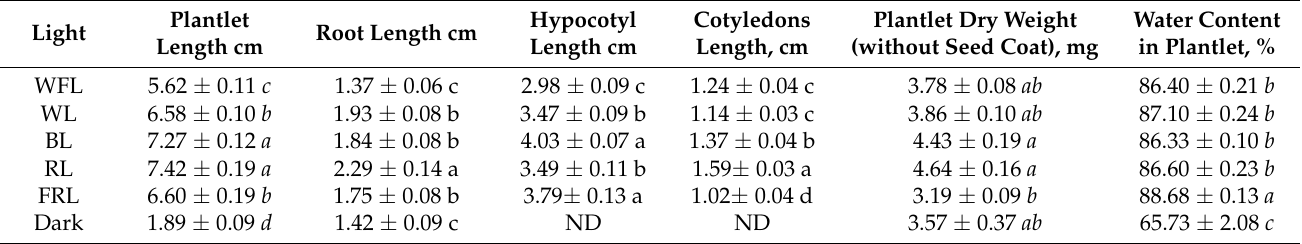
Table 2. Growth parameters of Scots pine plantlets on the 9th day of the experiment under differ- ent light and dark conditions.